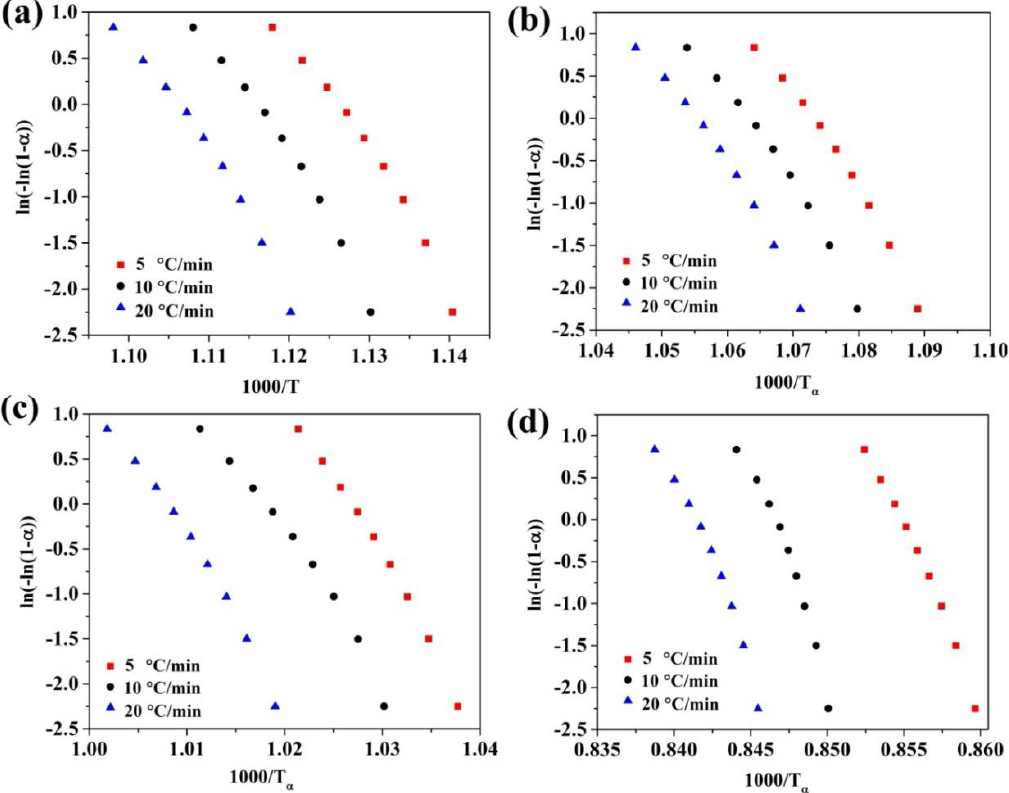
Figure 6. Plots of ln(−ln(1− α )) vs. 1000/ T α for (Fe 41 Co 7 Cr 15 Mo 14 Y 2 C 15 B 6 ) 100–0.25 Cu 0.25 BMGs with various heating rates. ( a ) Peak I; ( b ) peak II; ( c ) peak III; ( d ) peak IV.